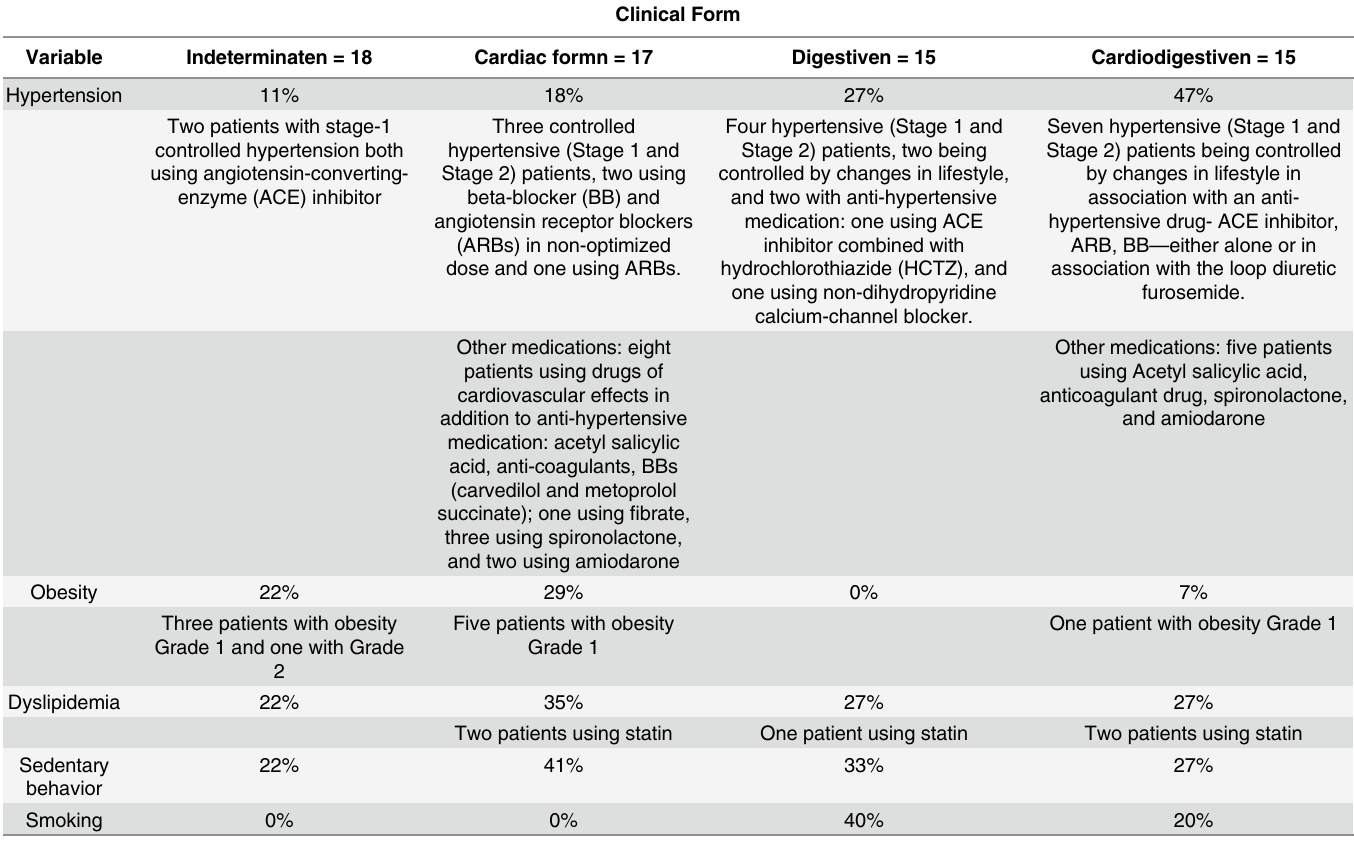
Table 1. Cardiovascular risk factors of chronic chagasic subjects from the Northeast of Brazil included in this investigation. Clinical